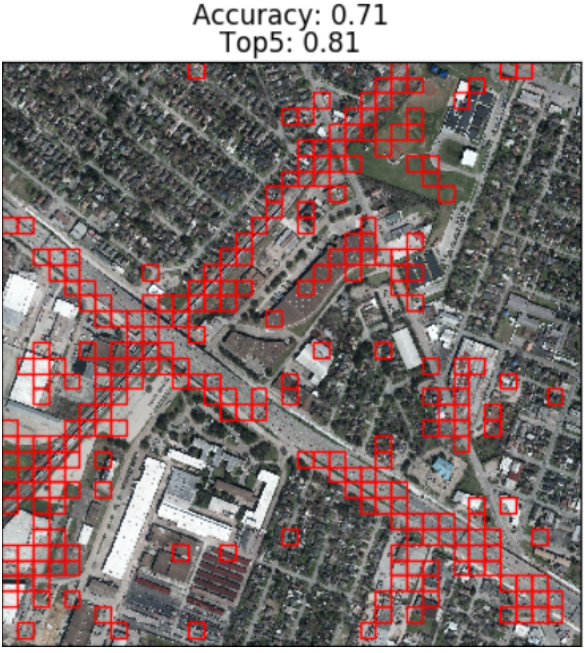
Figure 7. Evaluation on test dataset.